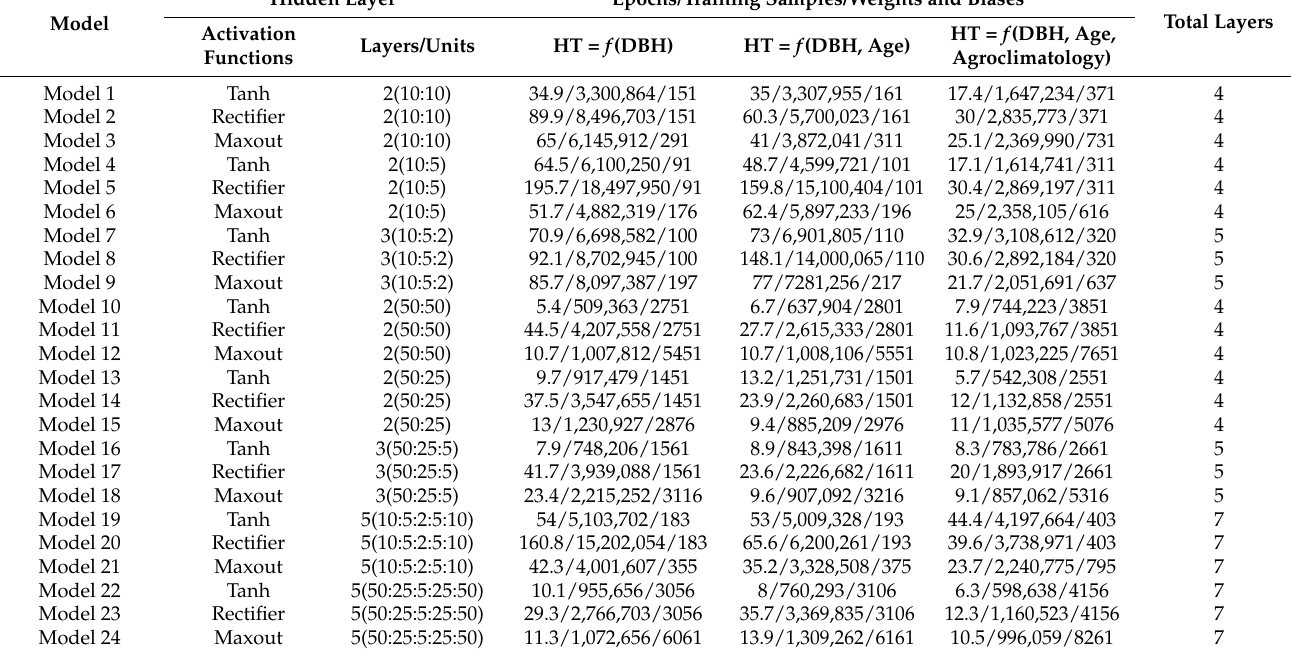
Table 2. State and architecture of each model trained according to the three functions evaluated for the predictions of the total height of the Guazuma crinita Mart. trees in the Peruvian